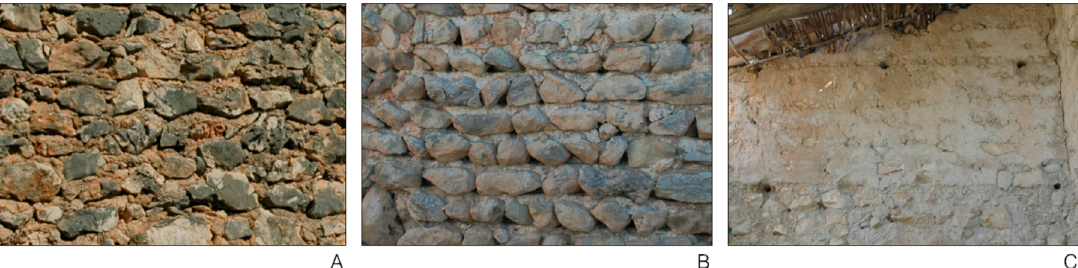
Figure 6. Compilation of detected wall fabrics. ( A ): Rubble stone masonry, ( B ): Coursed rough stone masonry ( C ): Tapia.